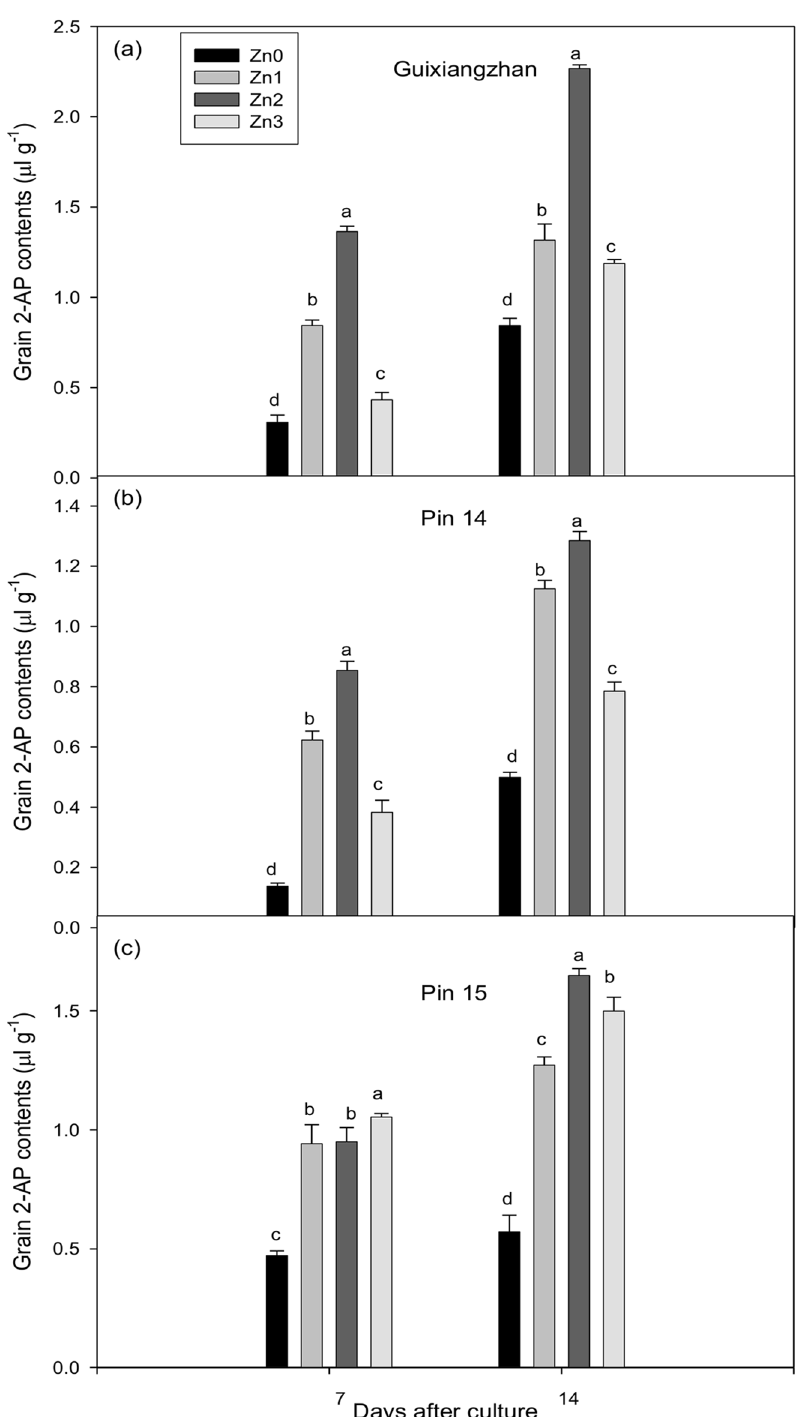
Fig 2. Effect of Zn supplementation on accumulation of 2-AP concentrations ( μ l g -1 ) in grains of detached aromatic rice panicles in vitro . Means in the same harvested stage by different lower case letters for the same variety differ significantly at P (cid:2) 0.05 by DMR test. Capped bars above means represent S.E. of three replicates.